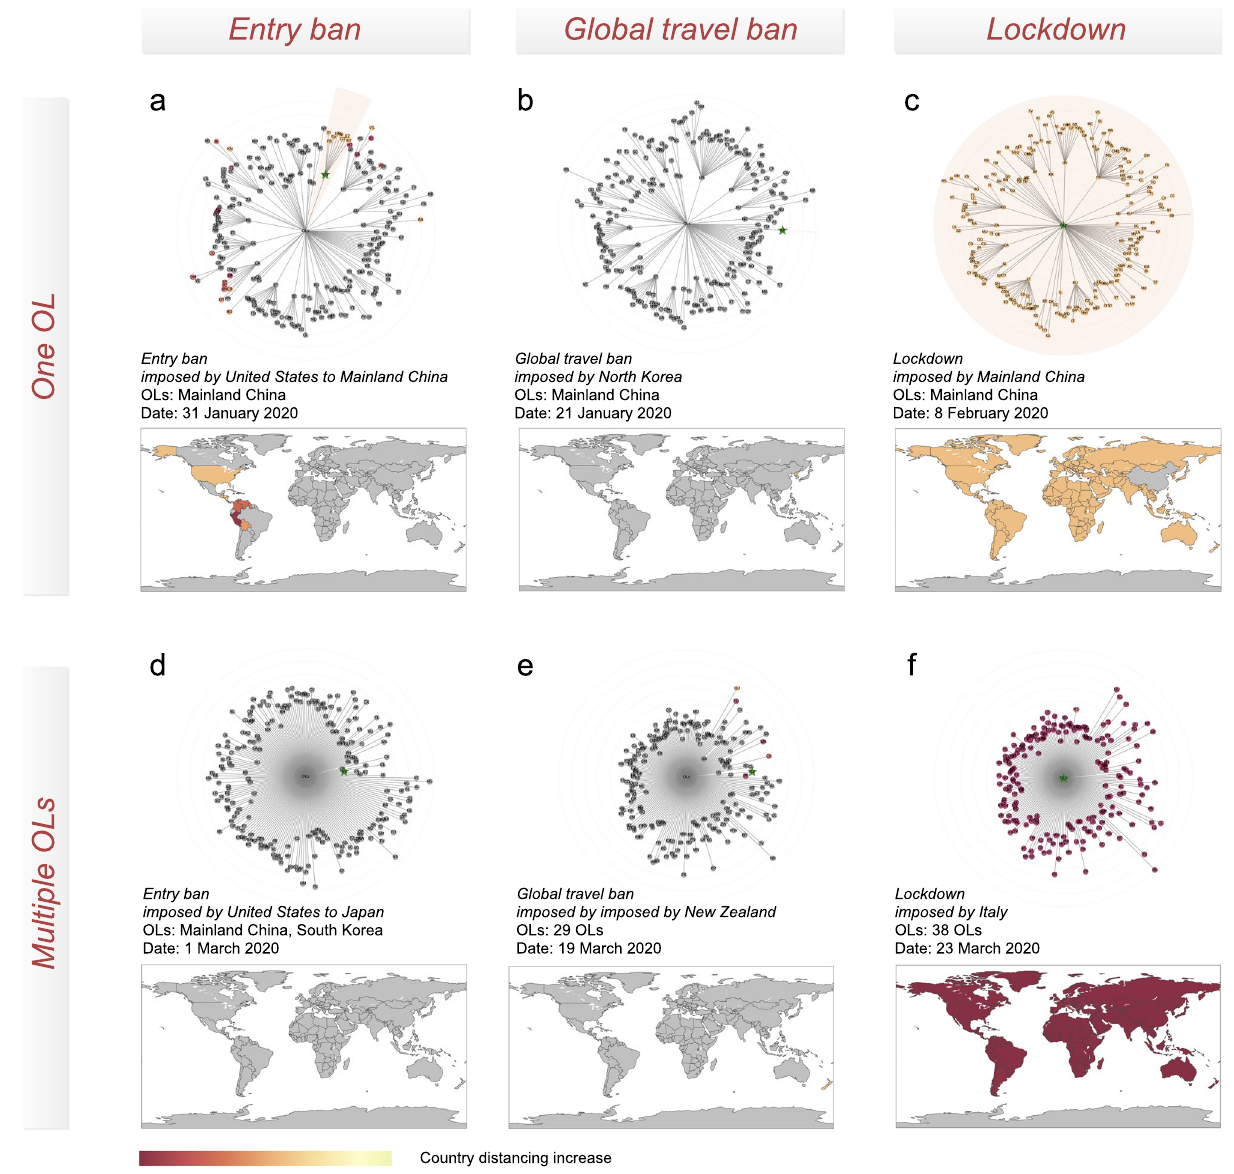
Fig. 5 Understanding how travel restrictions distance countries from outbreak locations (OLs). Corresponding to Figs. 3 and 4, the impact of six example travel restrictions on each geographical area are visualized through the shortest path tree and global maps. a Entry bans imposed by the United States to Mainland China. b Global travel ban imposed by North Korea. c Lockdown imposed by Mainland China. d Entry bans imposed by the United States to Japan. e Global travel ban imposed by New Zealand. f Lockdown imposed by Italy. The paths from root (OLs) to other nodes (areas) construct the shortest path tree. The area that imposed travel restriction is marked with a green star, whereas the areas with no country distancing increase are in gray. The star area ’ s travel restriction directly increases its descendants nodes ’ distance from the OL. As the number of OLs grows in d – f (multiple OLs merge to the root), the geographical areas ’ country distancing is reduced. The colors of the areas in the trees correspond to the colors on the corresponding maps. See Supplementary Fig. 12 for the shortest path tree before any travel restrictions are